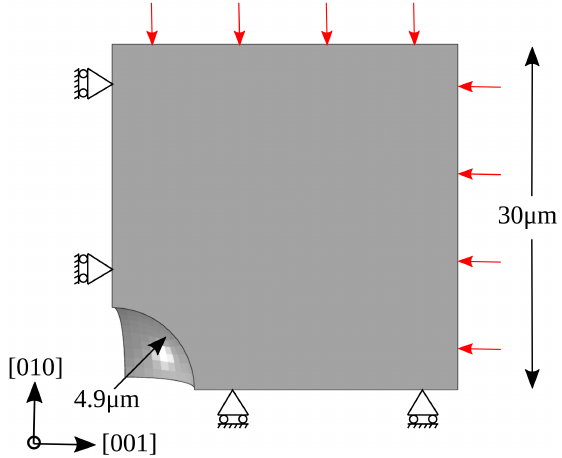
Figure 2. Planar view of a 3D model with 1/8th spherical void with loads and boundary conditions.